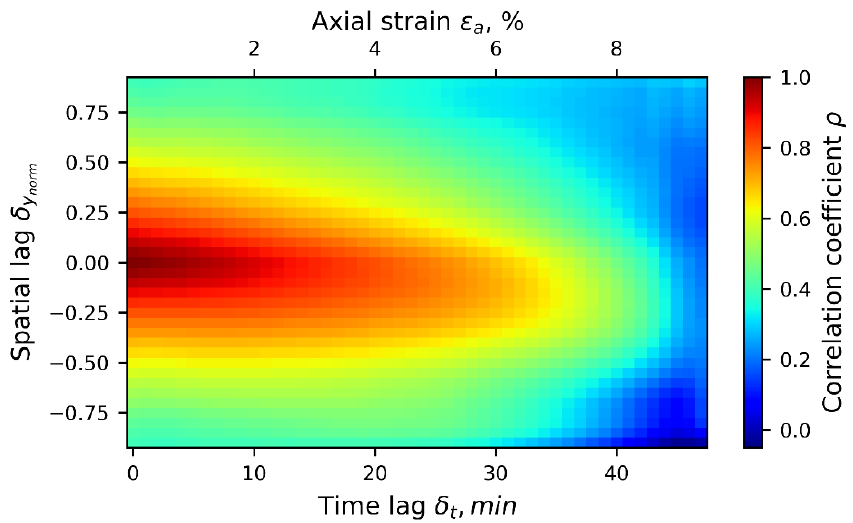
Figure 8. Smooth hypersurface representing the spatio-temporal empirical correlation structure for the 1D-T data ensemble of averaged vertical the 1D-T data ensemble of averaged vertical displacements.